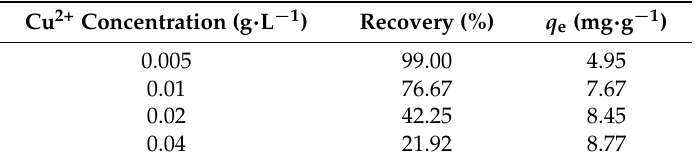
Table 5. Effect of the Cu 2+ concentration on the adsorption onto CNF. Experimental